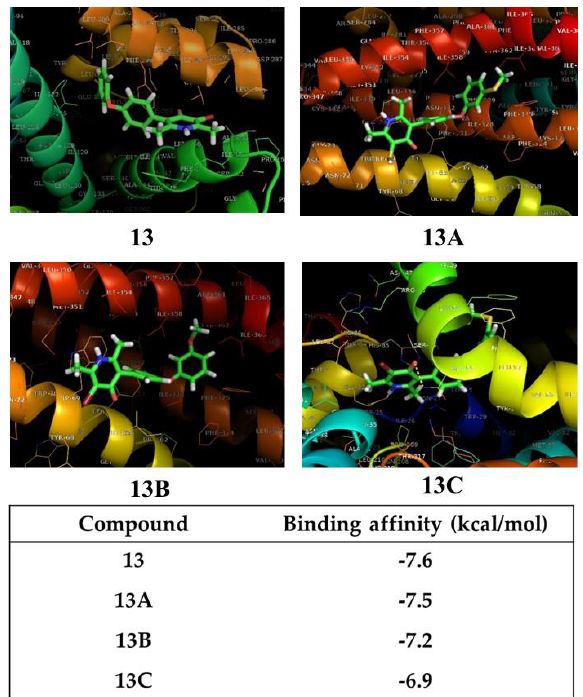
Figure 6. The new antimalarial structure predicted using Equation (3) and docking illustration using the 3D structure of cytochrome bc1 complex.